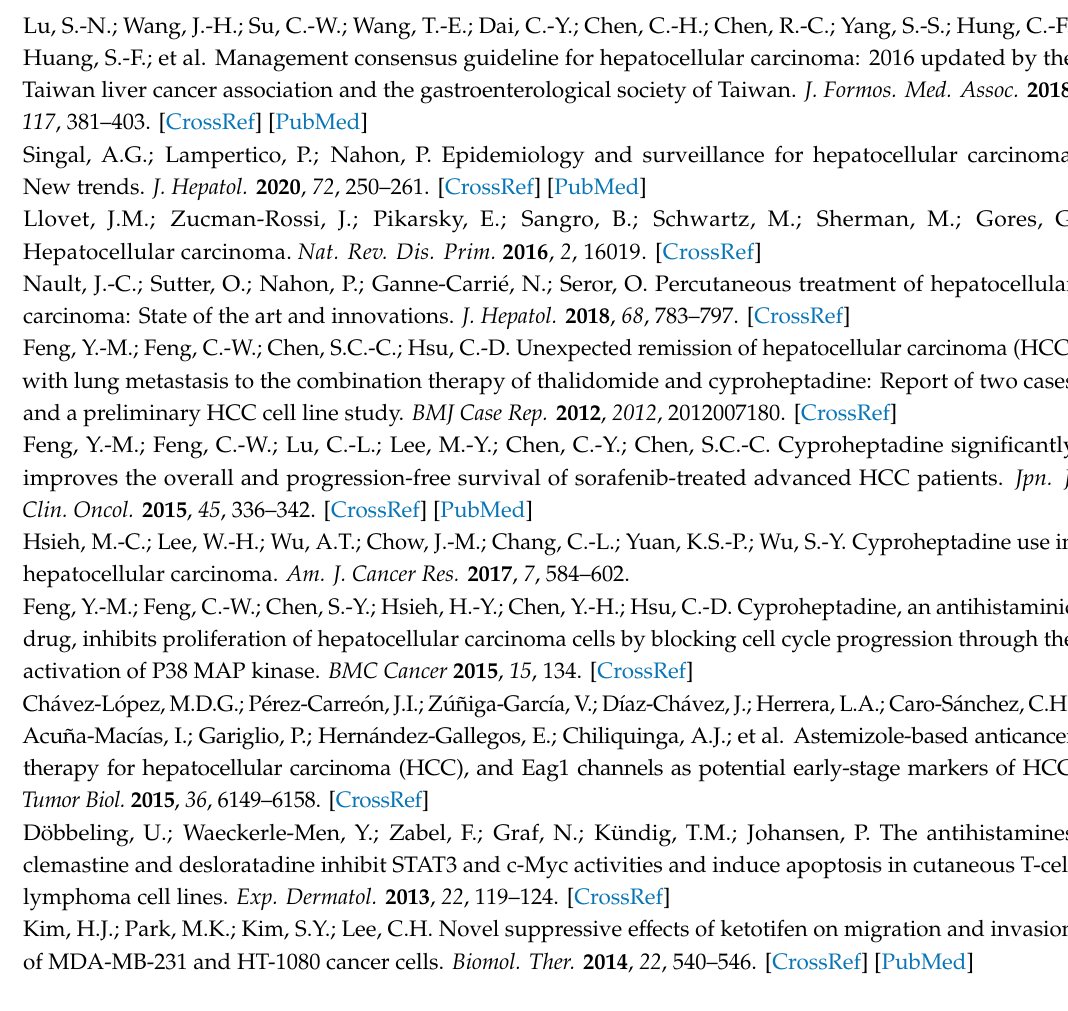
Figure S1: Uncropped Western Blots of Figure 3a., Figure S2: Uncropped Western Blots of Figure 3b, Figure S3: Uncropped Western Blots of Figure 3c, Figure S4: Uncropped Western Blots of Figure 5, Figure S5: Uncropped Western Blots of Figure